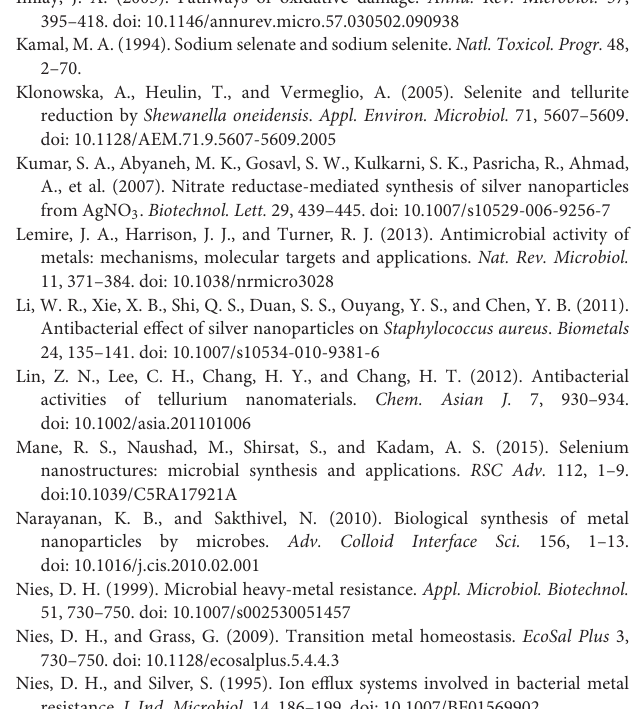
(D) . Effect of AuNS synthesized by crude extracts of MF09 in E. coli (E) and L. monocytogenes (F) . Black and blue lines represent the growth of control and NS-treated cells, respectively. Table S1 | Metal(loid)-resistant strains. Table S2 | MICs for the metal(loid)-resistant